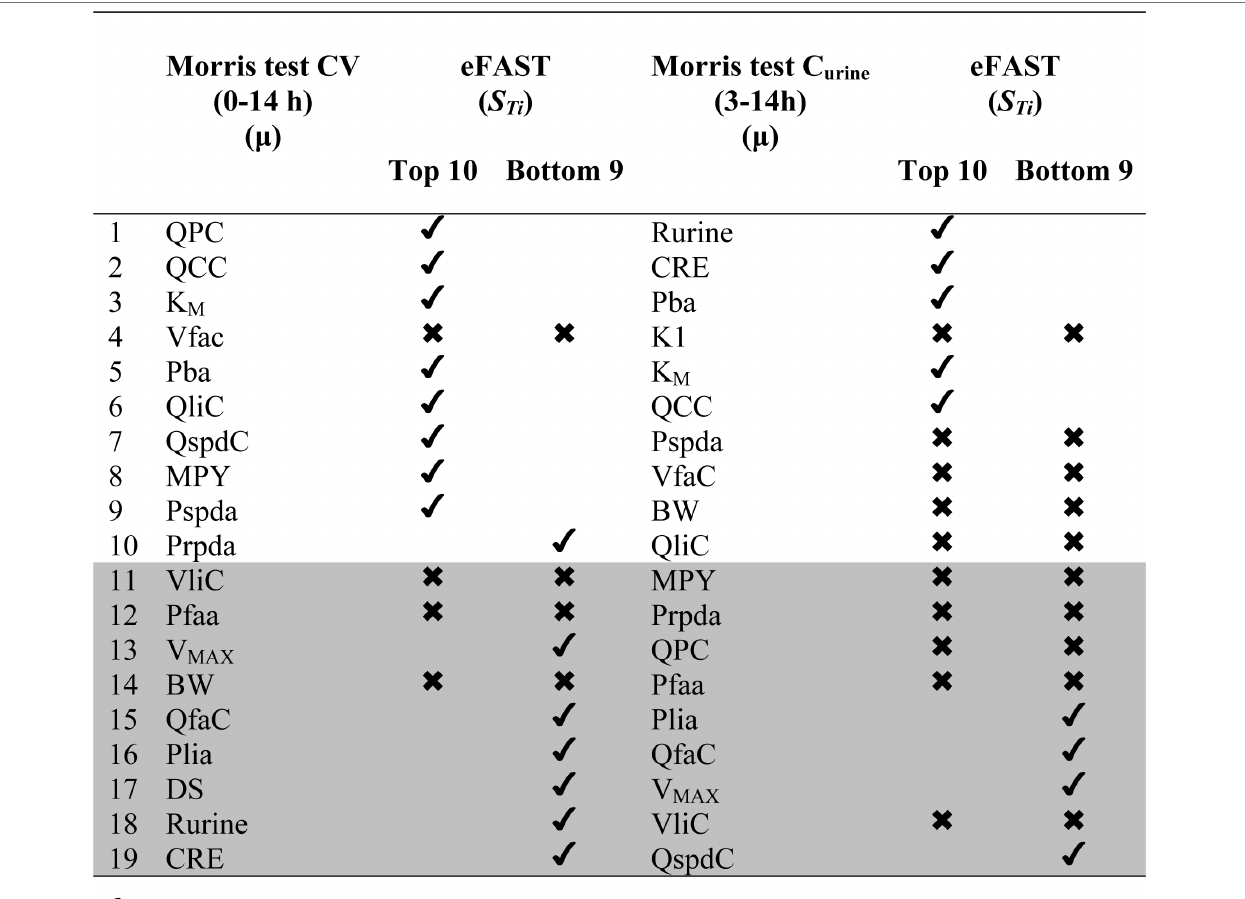
Table 2 | Ranking of model parameters: comparison of Morris test screening and